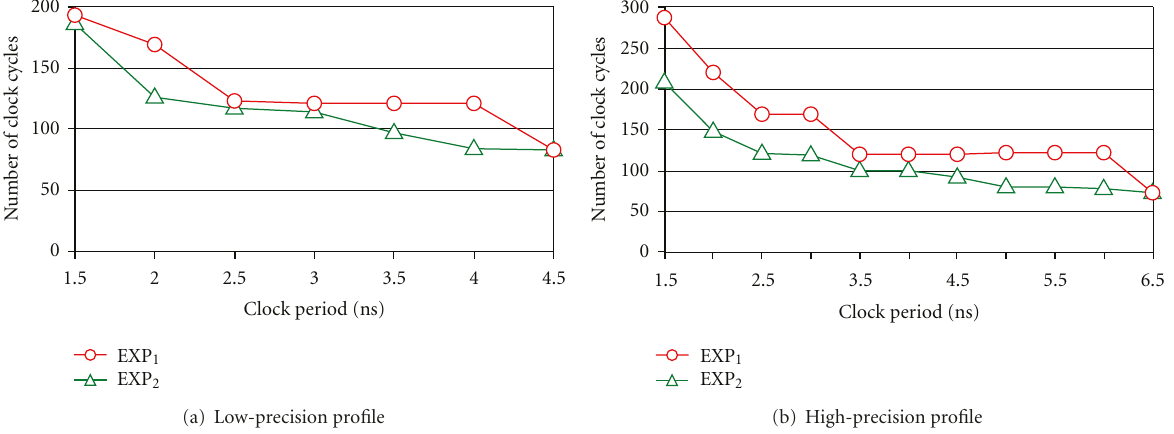
Figure 8: Design latency when the synthesis is constrained by the small set of operators—65 nm ASIC